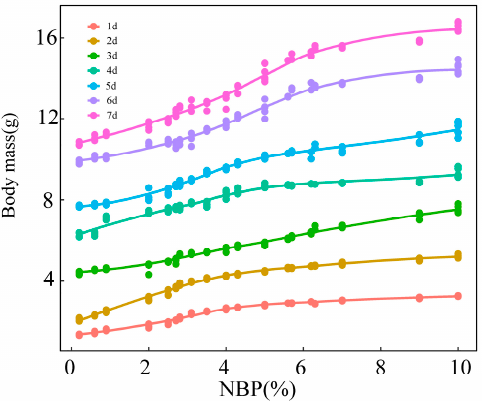
Figure 4. The relationship between nymph biomass proportion (NBP) and body mass of Asian short- toed lark ( Alaudala cheleensis ) nestlings ( n = 45). 1d, 2d, 3d, 4d, 5d, 6d, and 7d indicates the age of nestlings in days. NBP is the proportion of the daily grasshopper nymph biomass relative to the total biomass measured on all survey days.